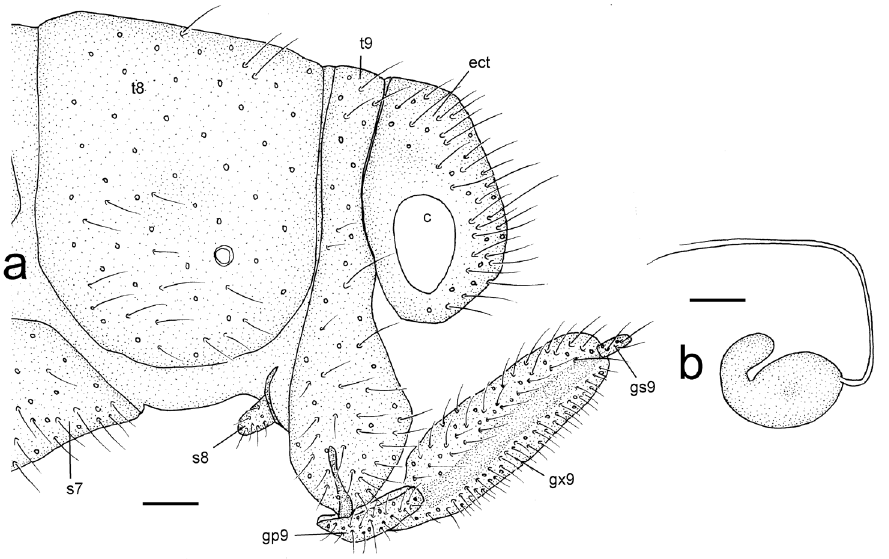
Figure 6. Female genitalia of Gryposmylus pennyi sp. n.: Additional abbreviations: gx9 , gonocoxite 9; gp9 , gonopophysis 9; gs9 , gonostylus 9. Scale bars: 0.2